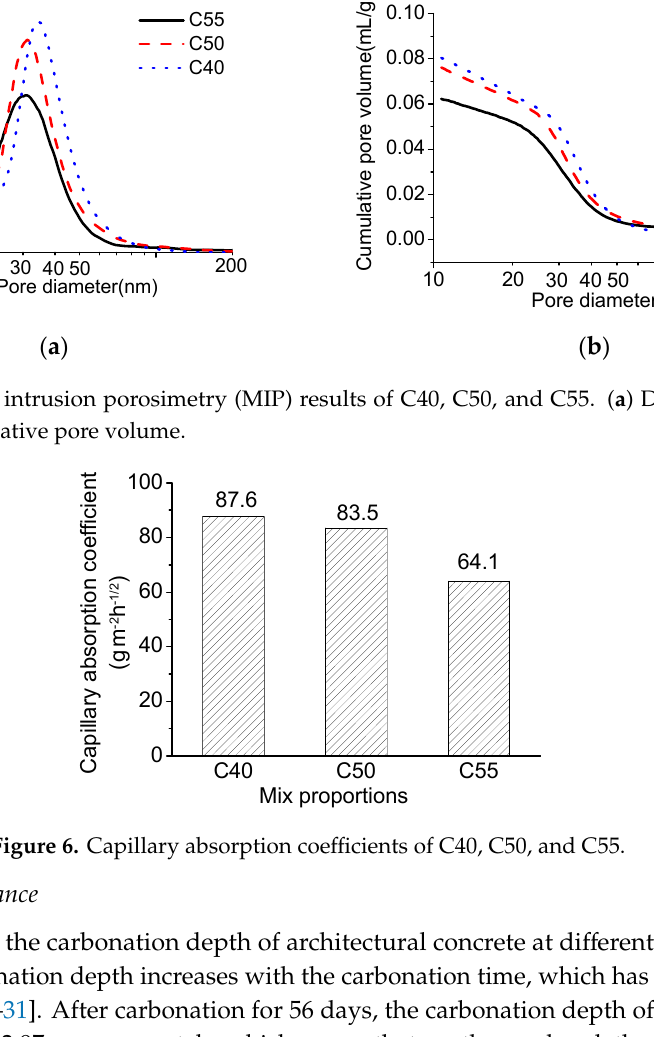
Figure 4. Amount of absorbed solution of C40, C50, and C55 changing with the square root of time.